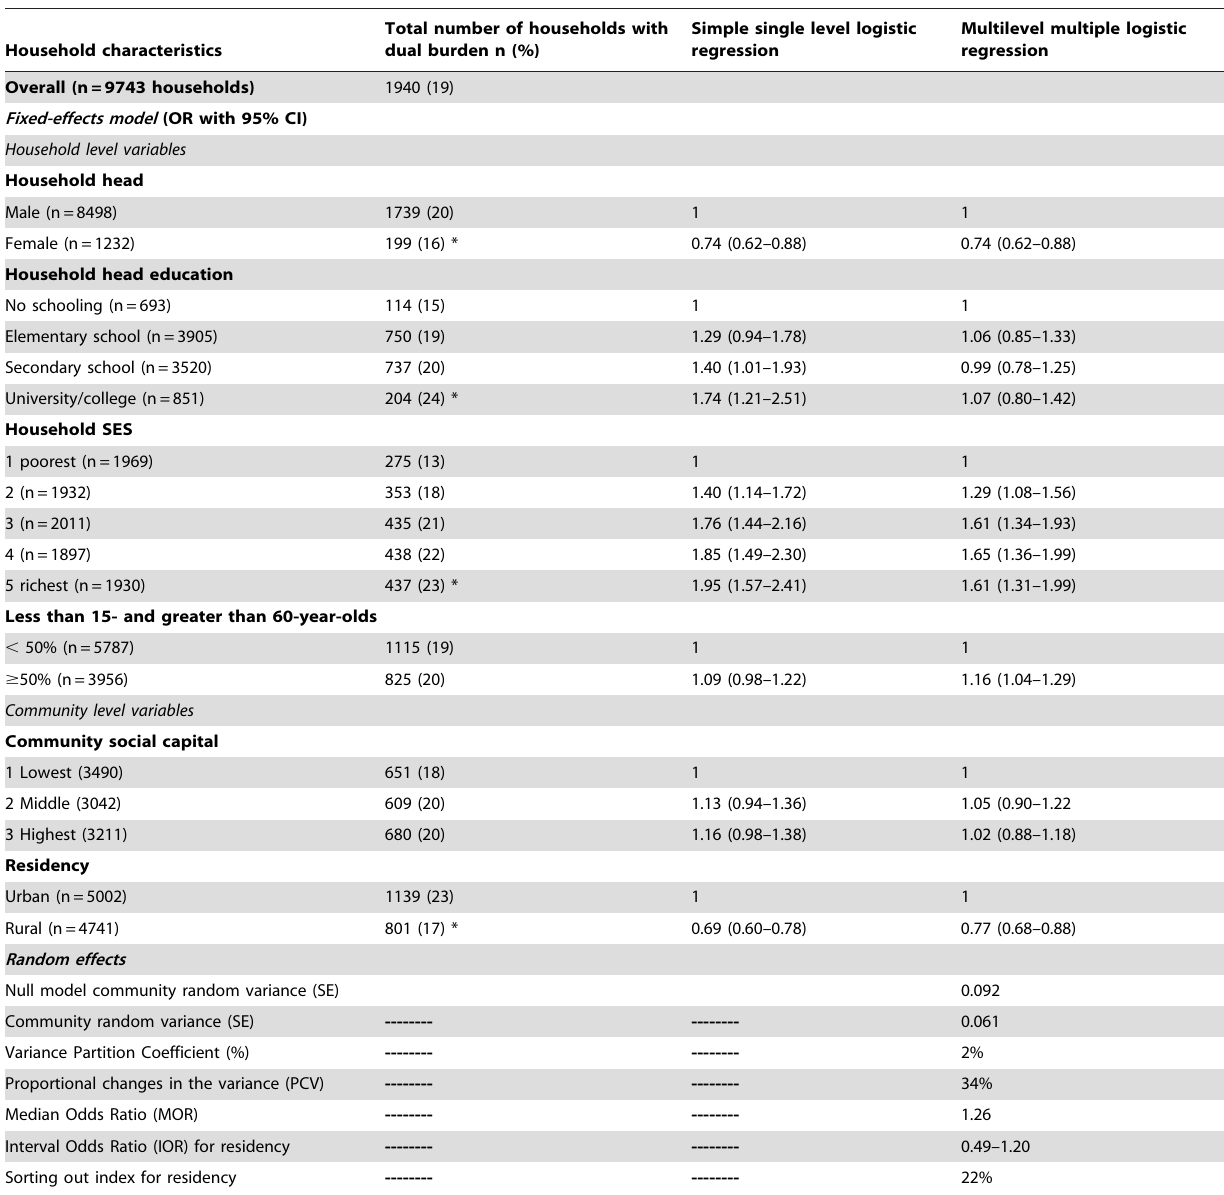
Table 2. Household and community level characteristics associated with the dual burden of malnutrition in Indonesia in